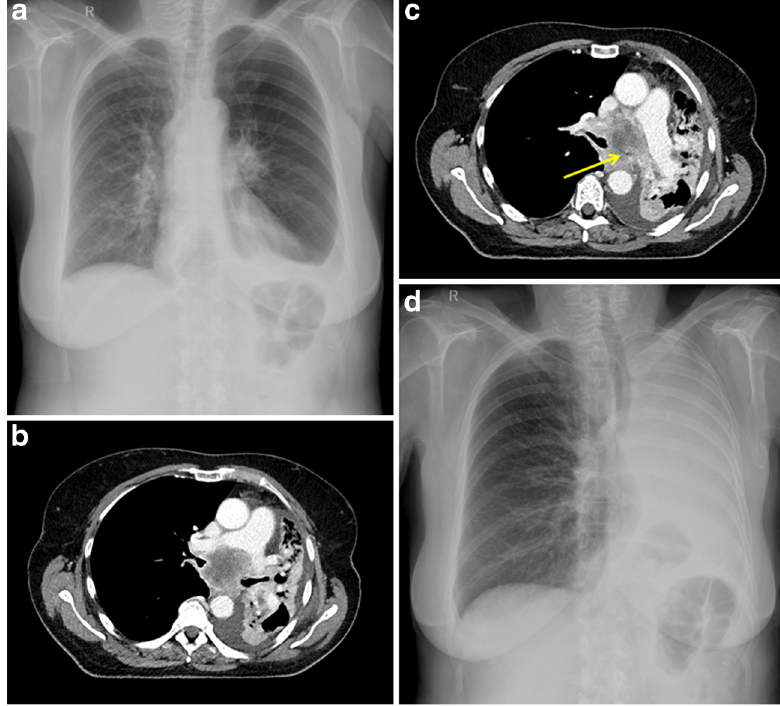
Fig. 6 A 64-year-old woman was referred to the pulmonologist for persistent cough and increasing dyspnea. a Erect postero-anterior chest radiograph at the time of presentation shows an enlargement of the left hilum, air trapping in the left hemithorax (suggestive of partial bronchial obstruction) and a left-sided pleural effusion. b Axial contrast-enhanced chest CT in mediastinal window 1 day after the chest radiograph shows a left hilar mass with infracarinal extension, c partially obstructing the left main bronchus ( yellow arrow ). Although there is only a short time frame betweenthe radiographandthe CT, there ismarkedvolume lossofthe left